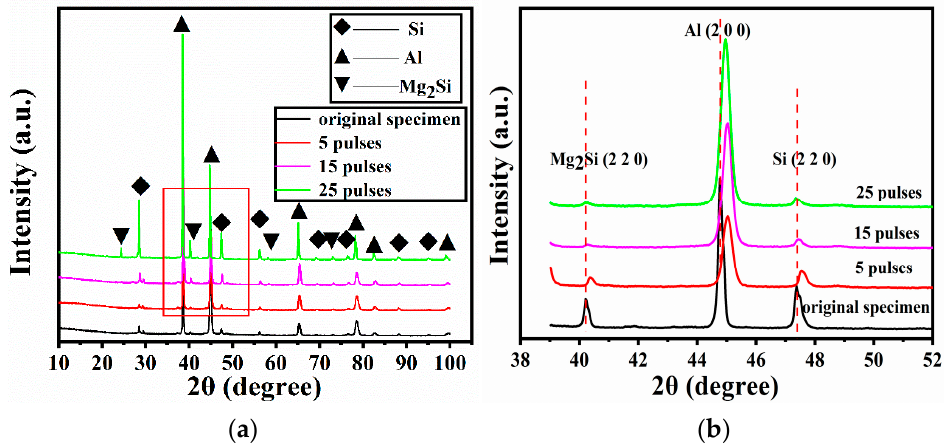
Figure 8. XRD plots of HCPEB-irradiated and HCPEB-unirradiated Al–20Si–5Mg–0.7Ce alloy surface. ( a ) Entire XRD plot; ( b ) enlarged plot of the Mg 2 Si(220), Al(200), and Si(220) peaks.